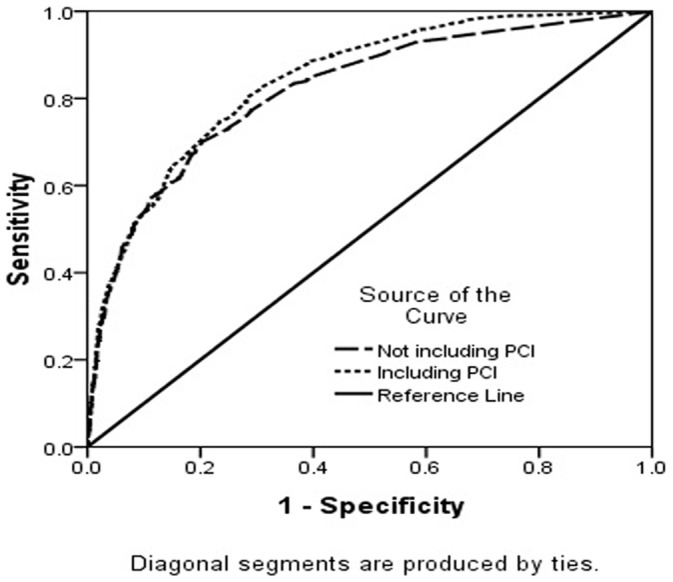
Receiver-operator characteristic curves (ROCs) of the predicting performance of PCI on 30 days mortality.The curves are based on risk-prediction models incorporating 16 clinical covariates that either include the PCI or did not include PCI. The area under the ROC curve (AUC) for mortalities was 0.841(0.824–0.858) and 0.819(0.799–0.839) for the risk model with and without the PCI separately (both P<0.001).